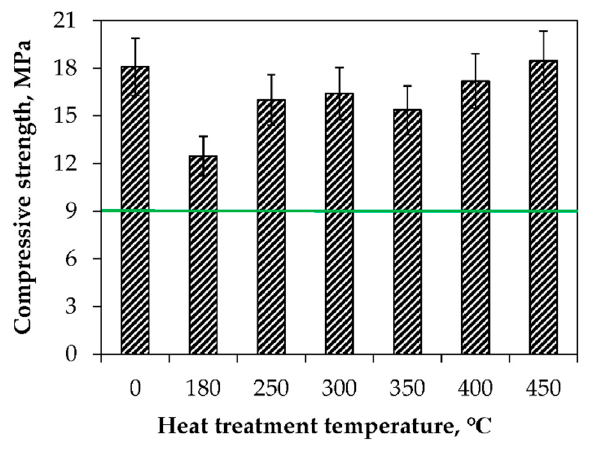
Figure 2. Compressive strength of MPP-FKN-W compound samples in dependence on the temperature of their heat treatment ( green line is the lower limit of the compressive strength requirements for vitrified HLW [1] ).